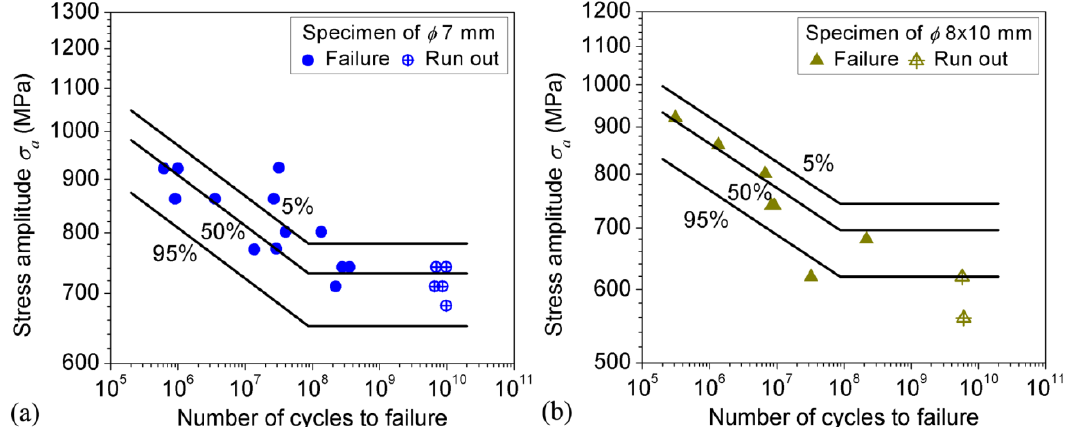
Figure 9. Comparison of predicted P-S-N curves with experimental data in literature [23] by using the fatigue strength data from the hourglass specimen with φ 3 mm in the minimum gauge section. ( a ) Comparison for the hourglass specimen with φ 7 mm in the minimum gauge section; ( b ) Comparison for the dogbone specimen with φ 8 × 10 mm in straight section.